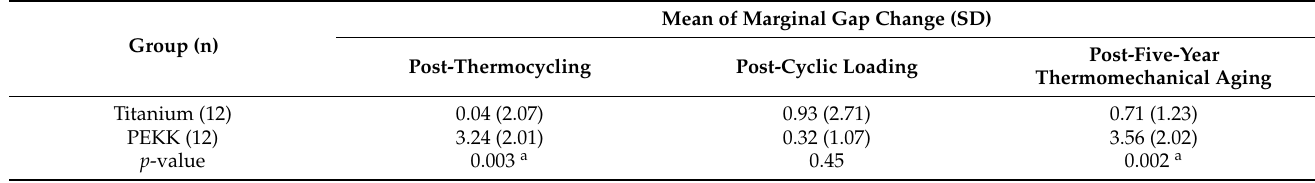
Table 2. Mean ( µ m) values of marginal gap change after different aging conditions.